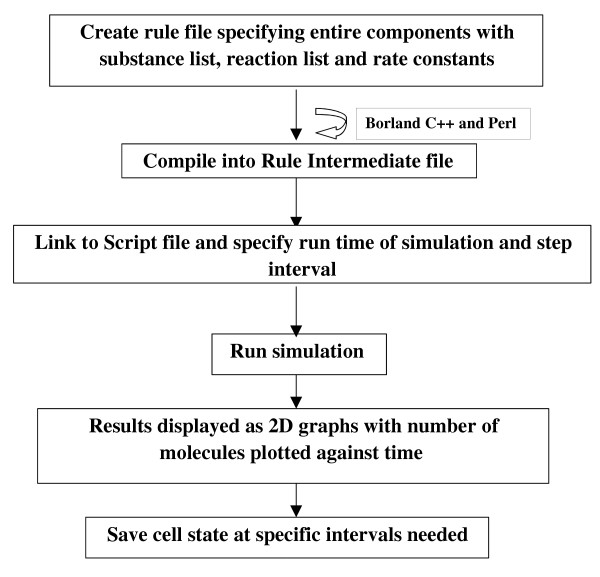
Schematic representation of steps in creation of simulation model using E-CELL system